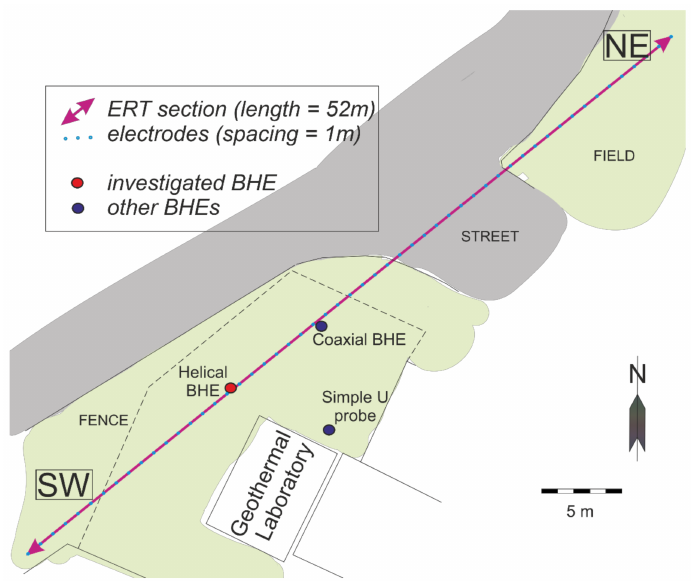
Figure 3. The electrical resistivity tomography (ERT) line used at the test site in Valencia. The first electrode was located at the south-west end of the